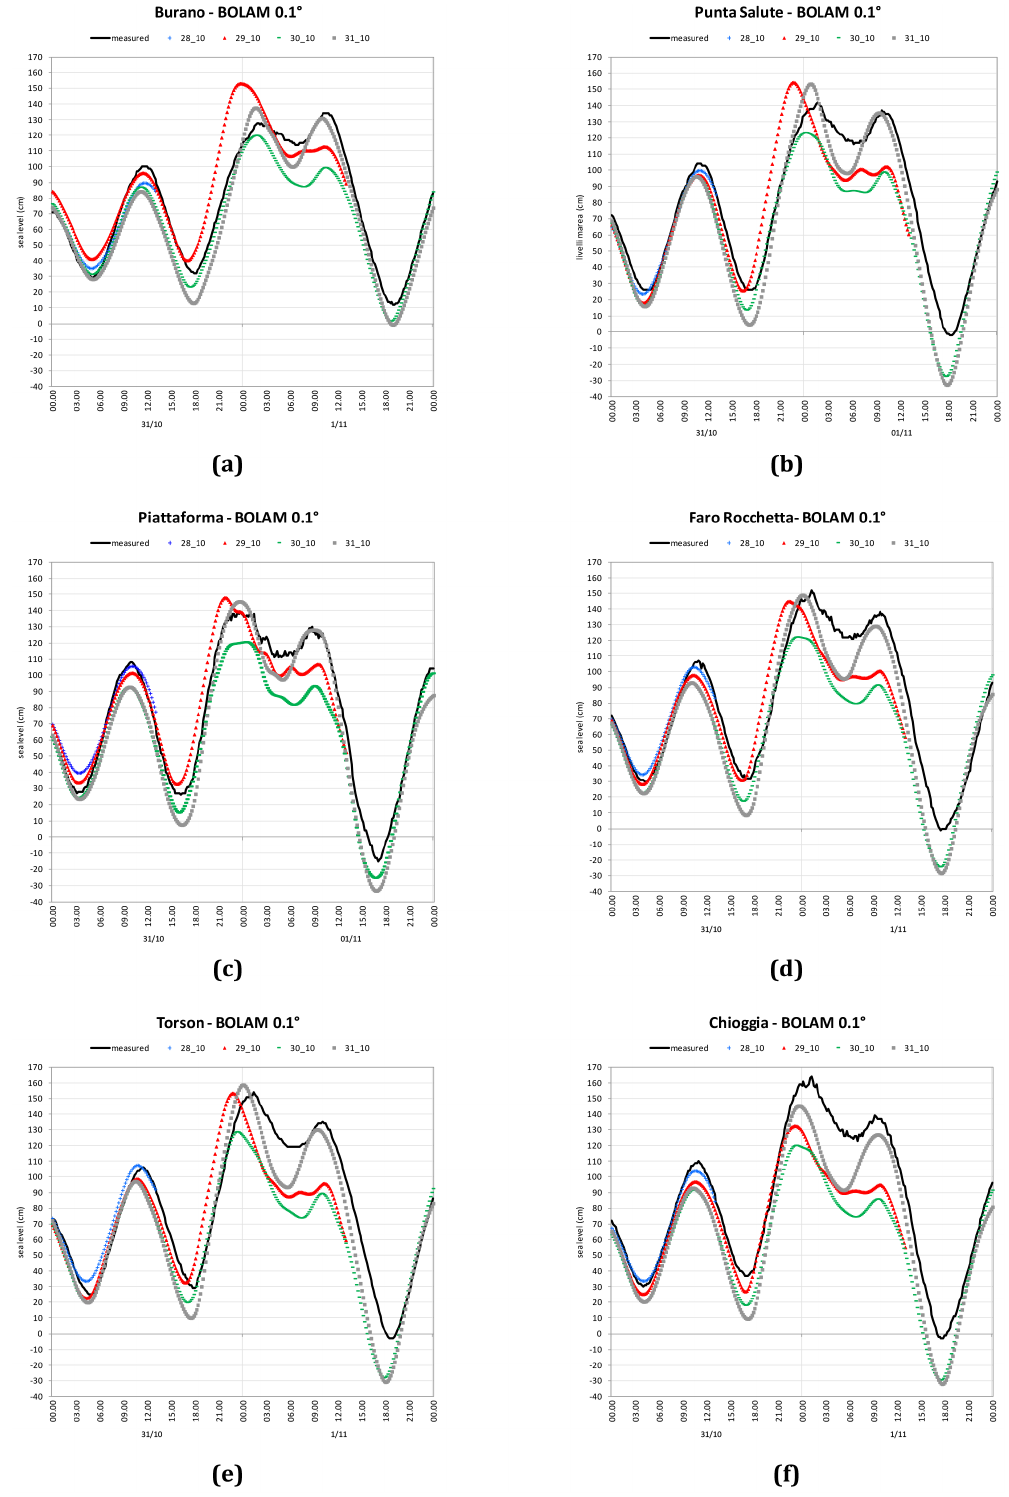
Figure 16. As in Fig. 15, but with the meteorological forecast forcing provided by the 0.1 ◦ BOLAM: (a) Burano; (b) Punta della Salute; (c) Piattaforma; (d) Faro Rocchetta; (e) Torson; (f)